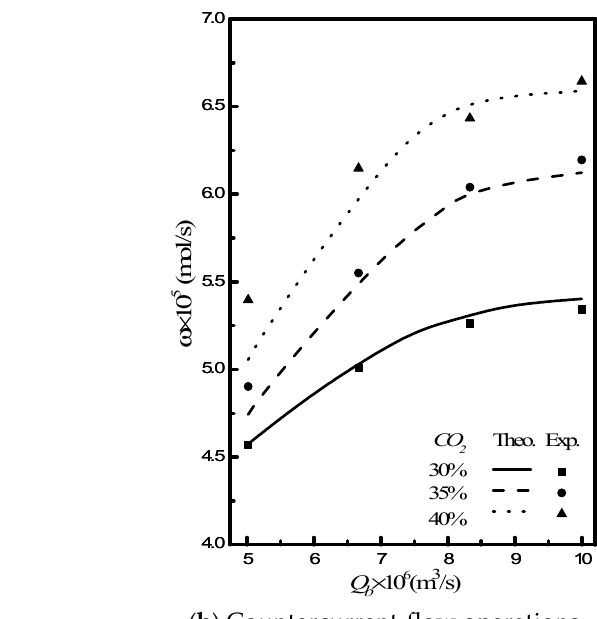
CO 2 concentrations for both flow patterns. Notice that the higher inlet CO 2 concentration results in the higher CO 2 absorption rate but the lower absorption efficiency, as shown in Figures 8 and 9, respectively. In addition, the CO 2 absorption efficiency is found to be increased with increasing absorbent flow rate. One may find the experimental result is most consistent with the theoretical prediction at the lower absorbent flow rate. The dis- crepancy between theoretical predictions and experimental result is increasing as the ab- sorbent flow rate increases. Figure 8. Comparisons of CO 2 absorption rate with various operating parameters. Figure 9 illustrates the deviation between the theoretical predictions and experi- mental results of CO 2 absorption efficiency that vary with absorbent flow rate and inlet